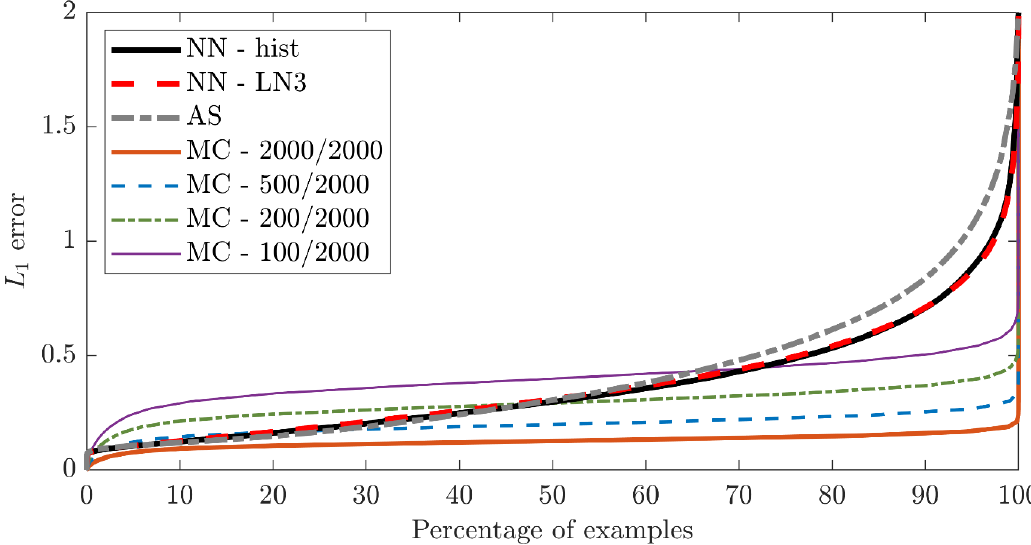
Figure 10. Cumulative distributions of the L 1 errors for the final histogram NN (thick solid black line) and LN3 NN (thick dashed red line) on testing dataset 2 in comparison to the cumulative distribution of the L 1 errors for AS (thick dash-dotted gray line) and the cumulative distributions of L 1 differences for the alternative MC PDFs of TL generated with 2000 trials (thin solid orange line), 500 trials (thin dashed blue line), 200 trials (thin dash-dotted green line), and 100 trials (thin solid purple